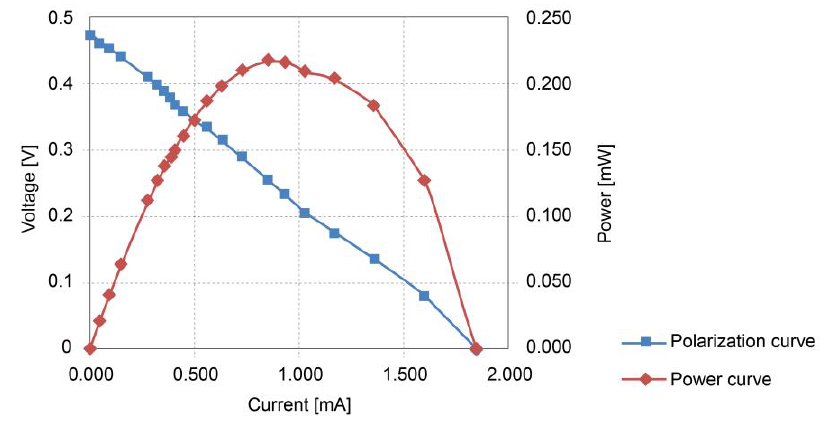
Figure 5. Parallel SMFCs power and polarization curves.